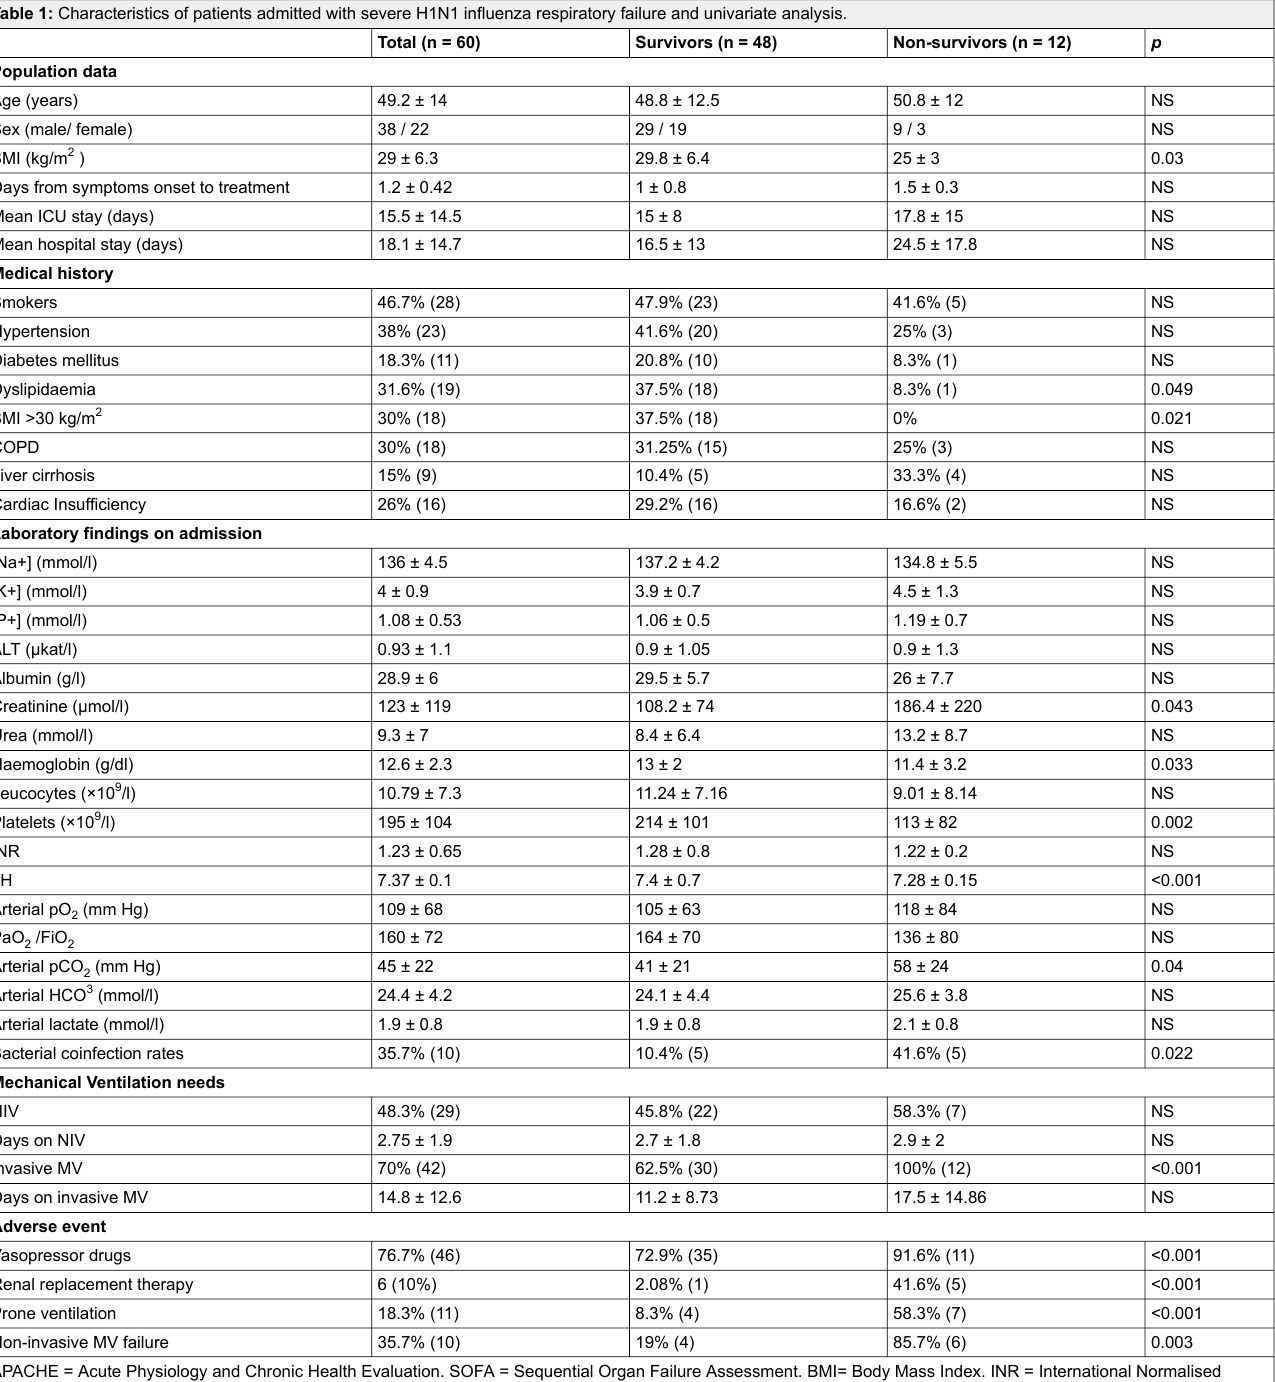
Table 1: Characteristics of patients admitted with severe H1N1 influenza respiratory failure and univariate analysis.